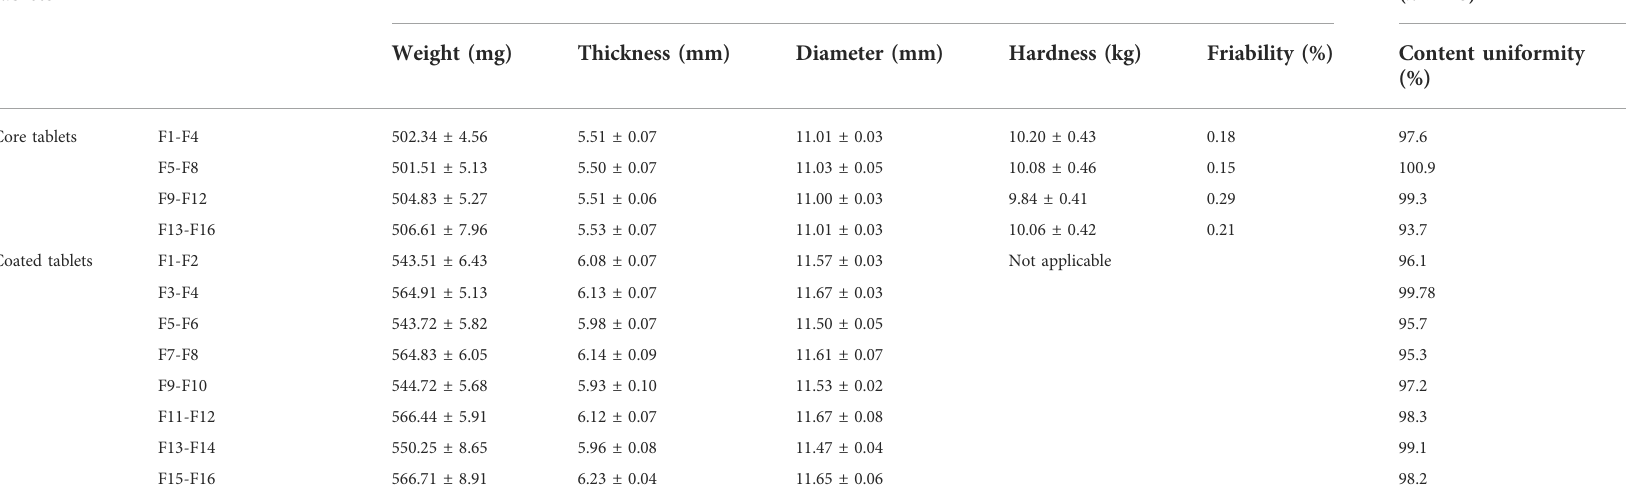
TABLE 5 Physicochemical quality characteristics of